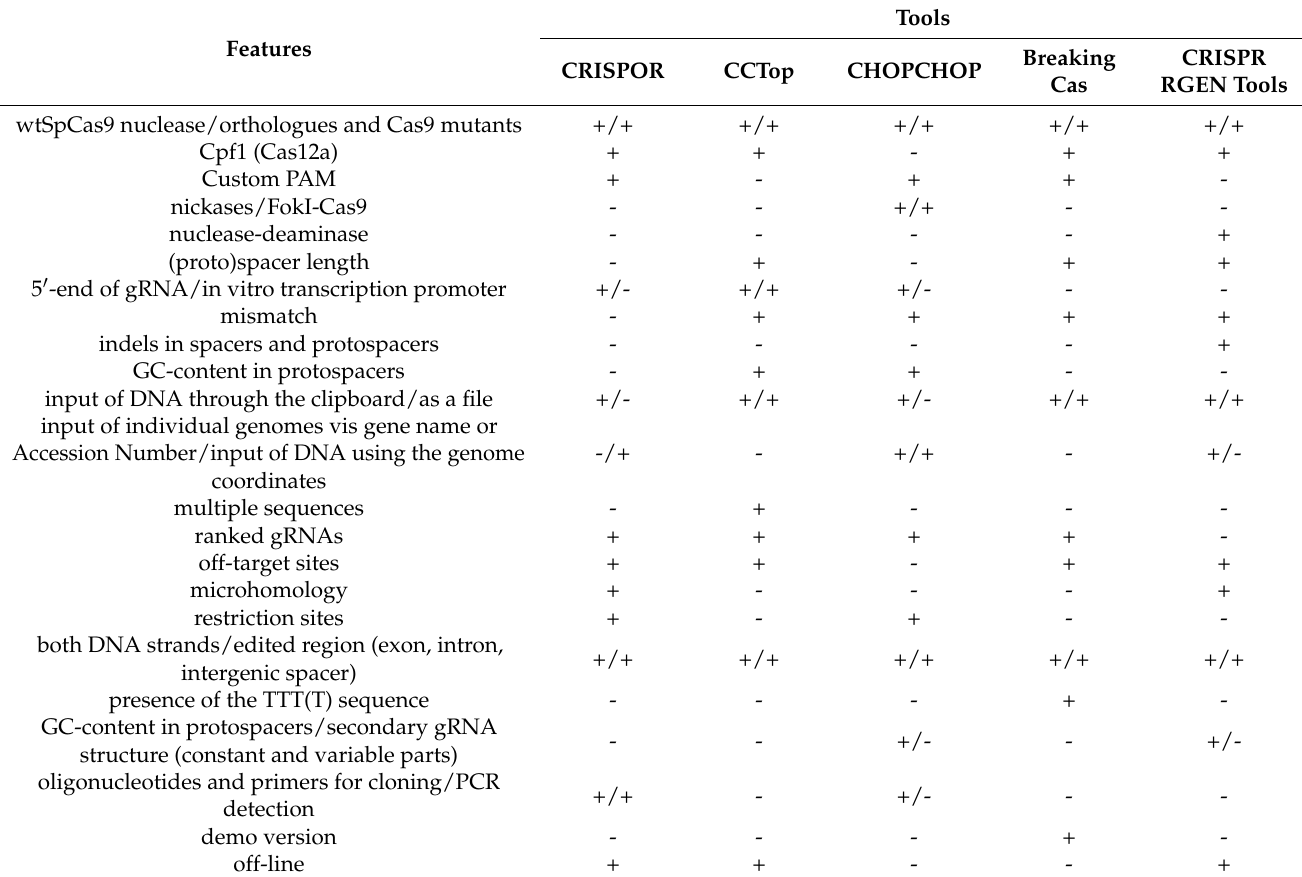
Table 6. The main characteristics of some tools for the design of gRNA for genome editing in cannabis.